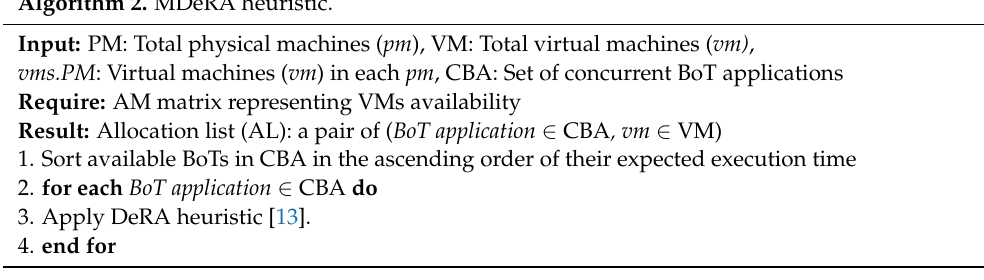
Algorithm 2. MDeRA heuristic.